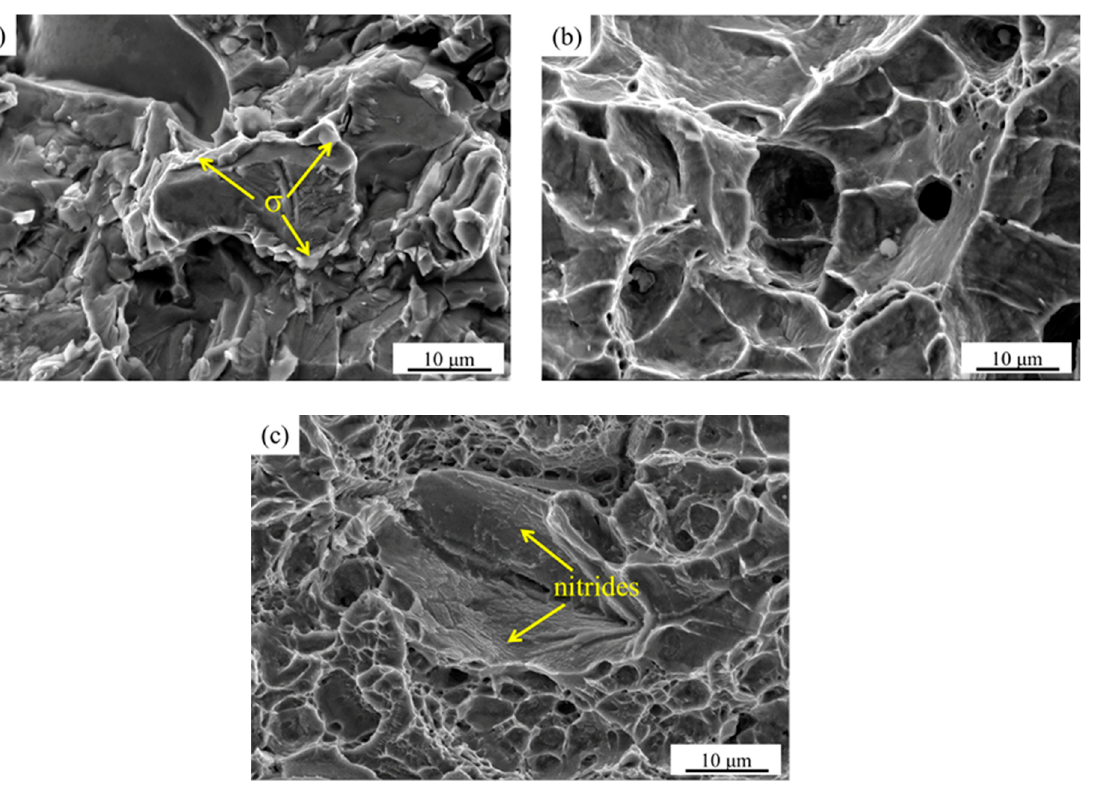
Figure 9. SEM images of impact fracture of the specimens after solution treatment at: ( a ) 1040 °C; ( b ) 1100 °C; ( c ) 1200 °C. ( b ) 1100 ◦ C; ( c ) 1200 ◦